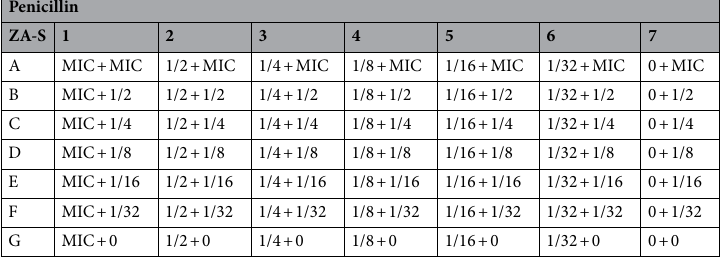
Table 1. Checkerboard matrix of penicillin and